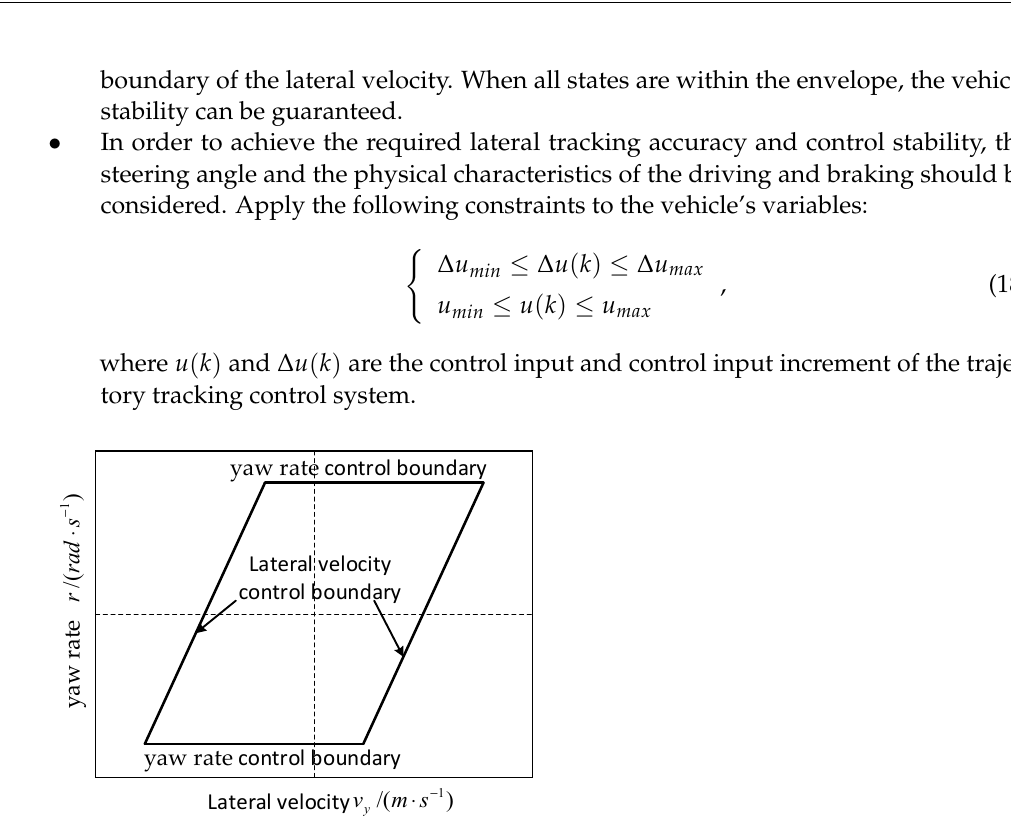
Figure 5. Schematics of envelope constraint of vehicle swing.